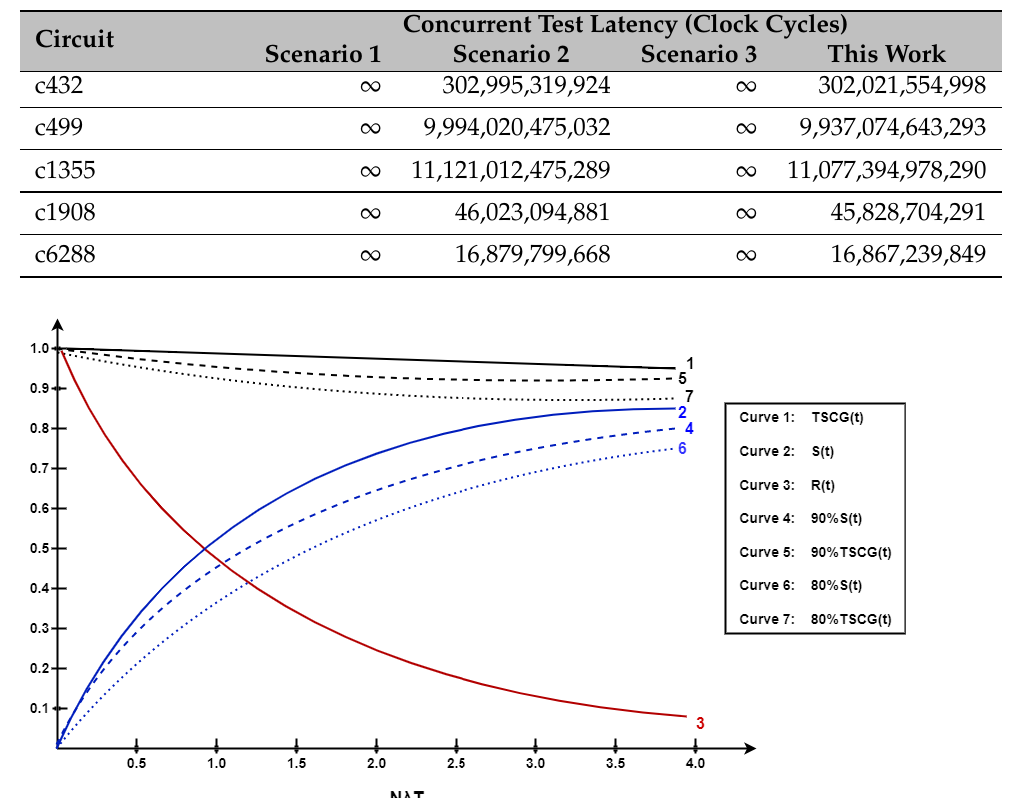
Figure 12. TSCG ( t ) under low-power mode (active for 10% of the total operating time) and when inputs do not have the same probability of occurrence and part of the inputs are not available: (1) all input values are available, (5) a case of 90% input values available, and (7) a case of 80% input values